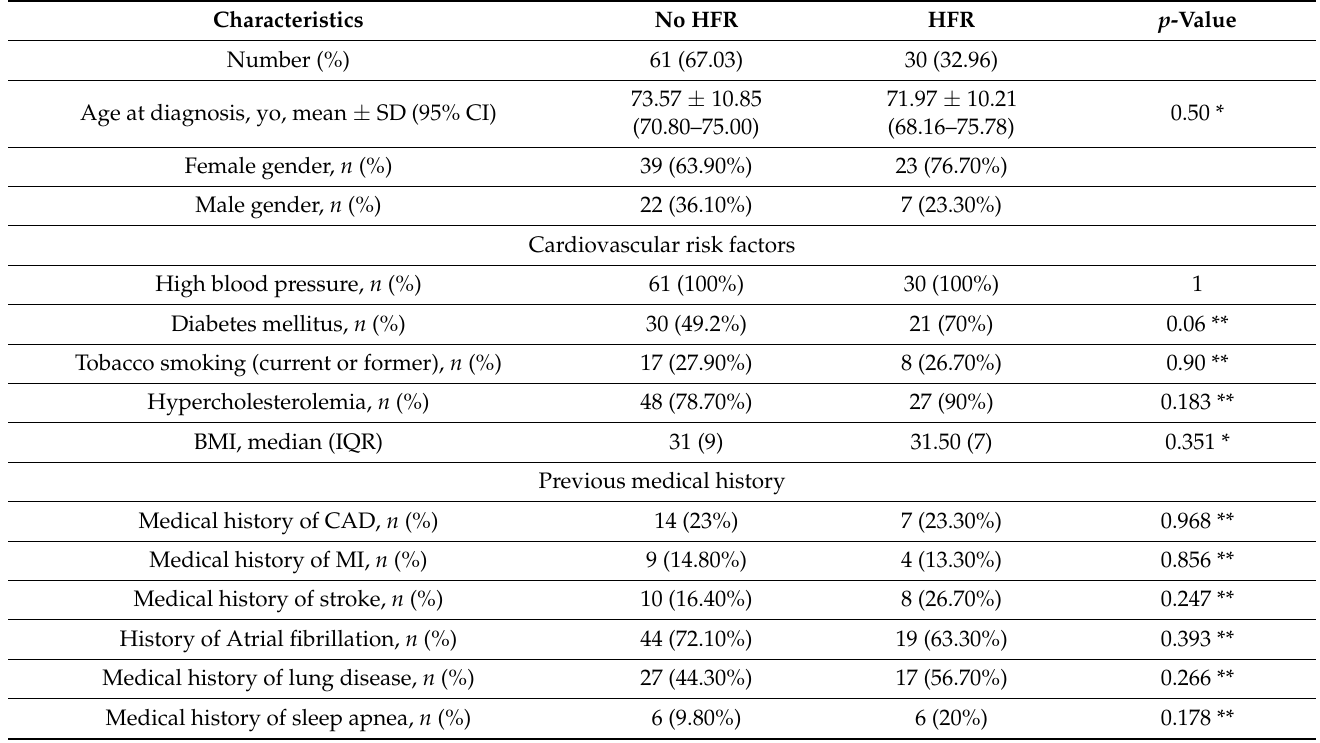
Table 1. Complete baseline characteristics of the patients with acute HfpEF according to HFR status ( n =